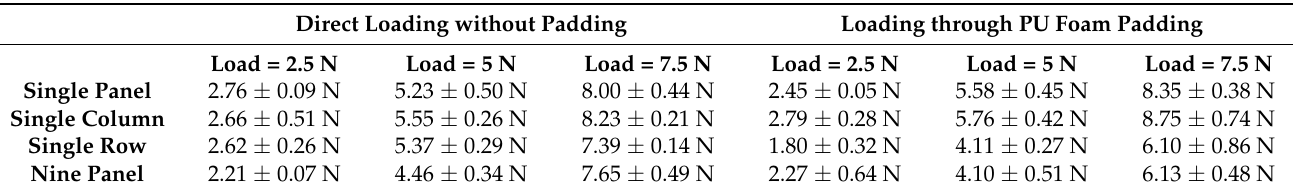
Table 2. Load predictions across four loading cases, three levels of loading, and two types of surfaces. Direct Loading without